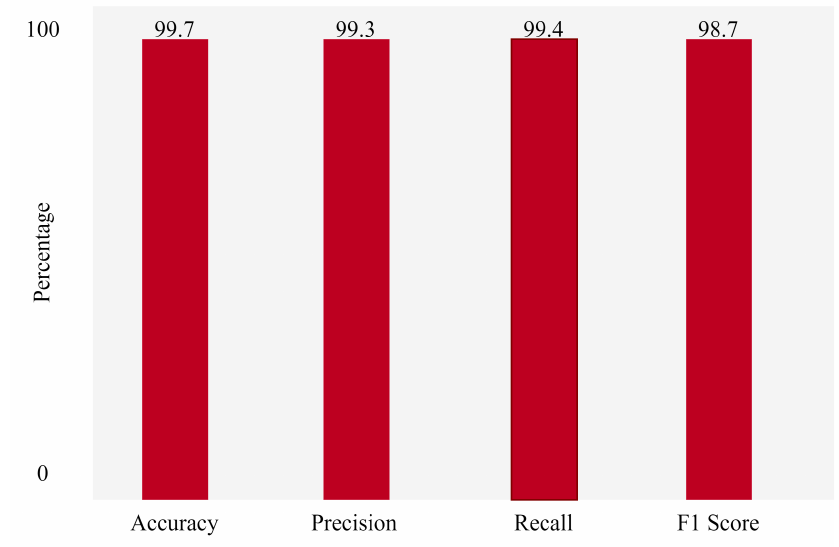
Figure 7. Evaluation of ENN on UNSW-NB15 with k-Means Clustering.